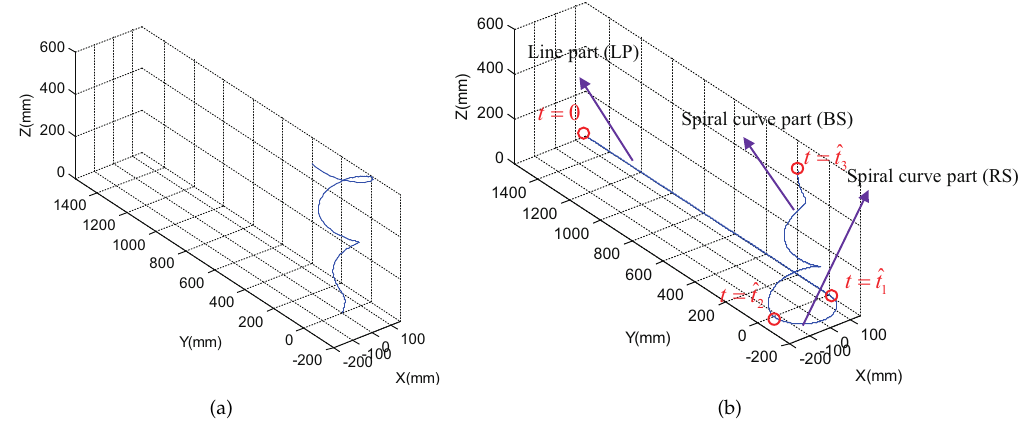
Figure 3. Spiral curves: ( a ) the regular spiral curve, and ( b ) the predefined spiral curve used in this